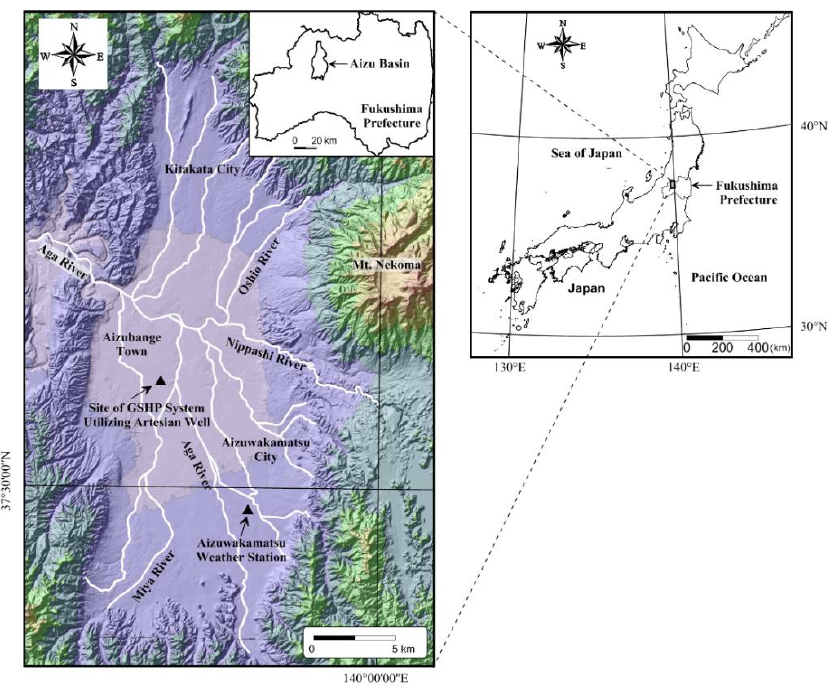
Figure 1. Location of the Aizu Basin.